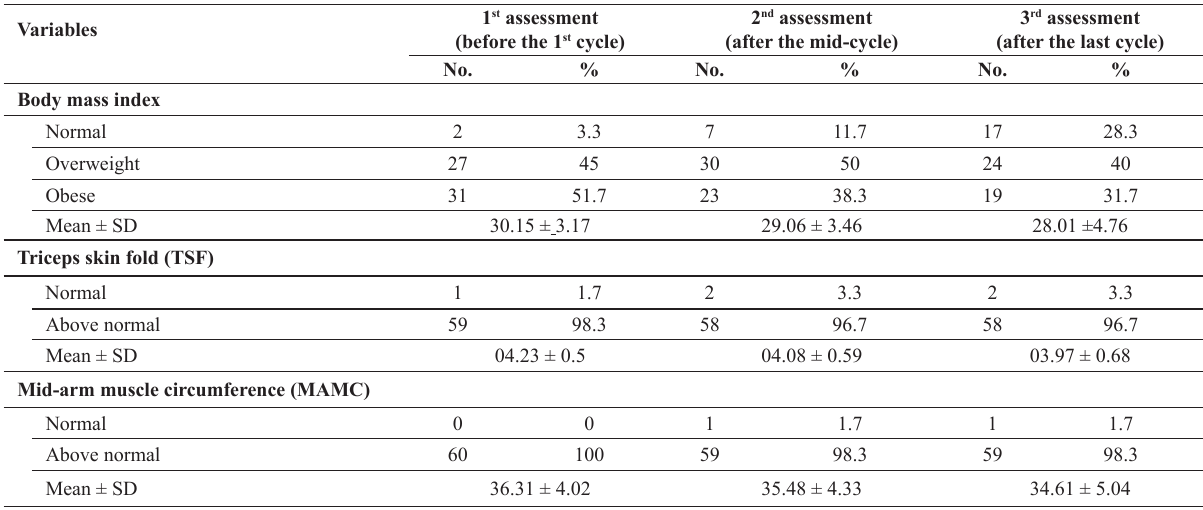
Table 3: Anthropometric measurements along the course of chemotherapy Variables